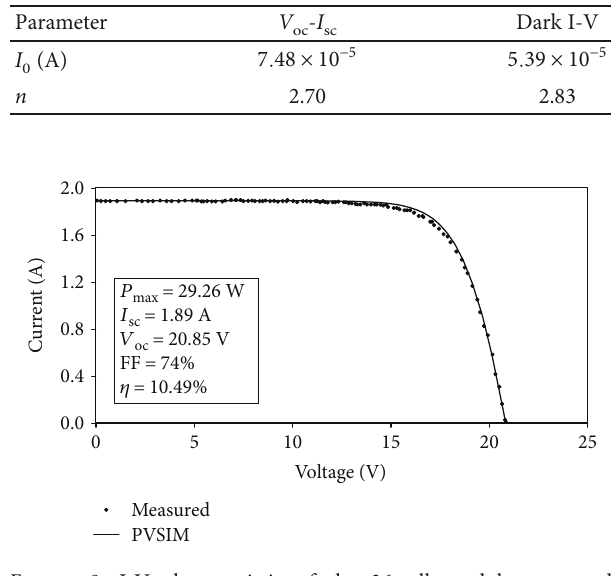
Figure 9: I-V characteristic of the 36-cell module measured (symbols) at STC and simulated (solid line) using PVSIM [8]. The performance parameters shown are those obtained from measurement. Table 3: I and n for the 36-cell module obtained from V 0 measurements compared to that simulated using PVSIM.